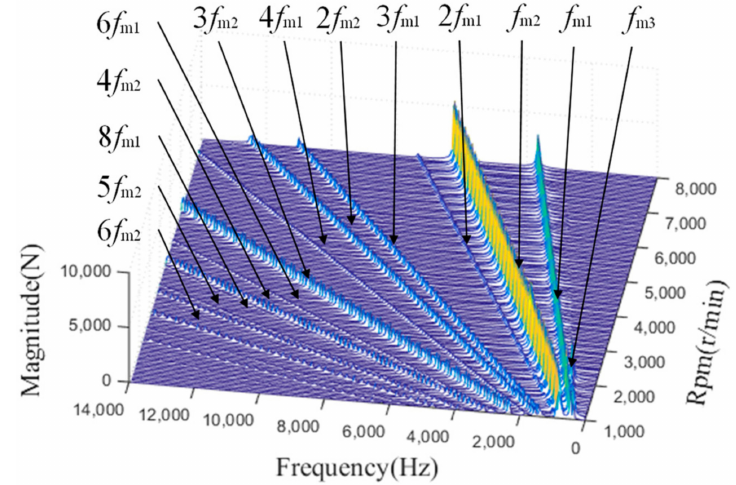
Figure 10. External meshing force of the second gear set.